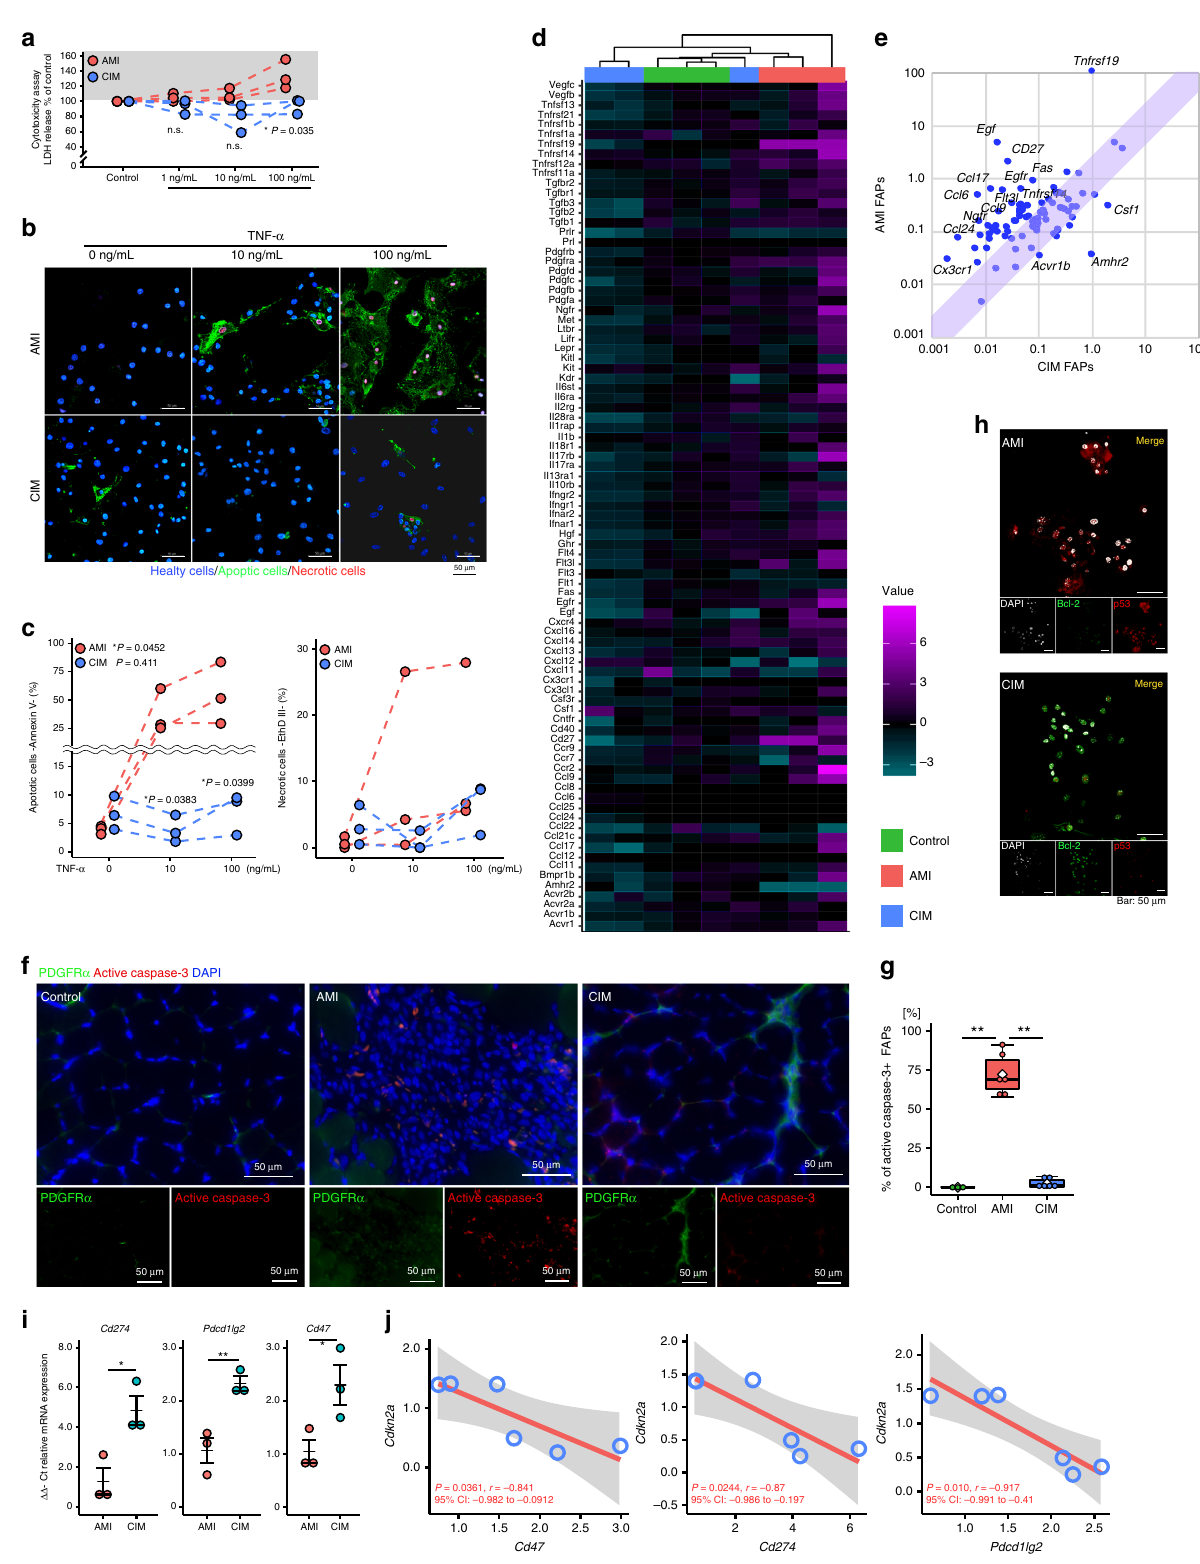
that FAP senescence is necessary to promote muscle regeneration and improve muscle function. Trp53 activation is required to promote muscle regeneration . To investigate whether FAP senescence is necessary to